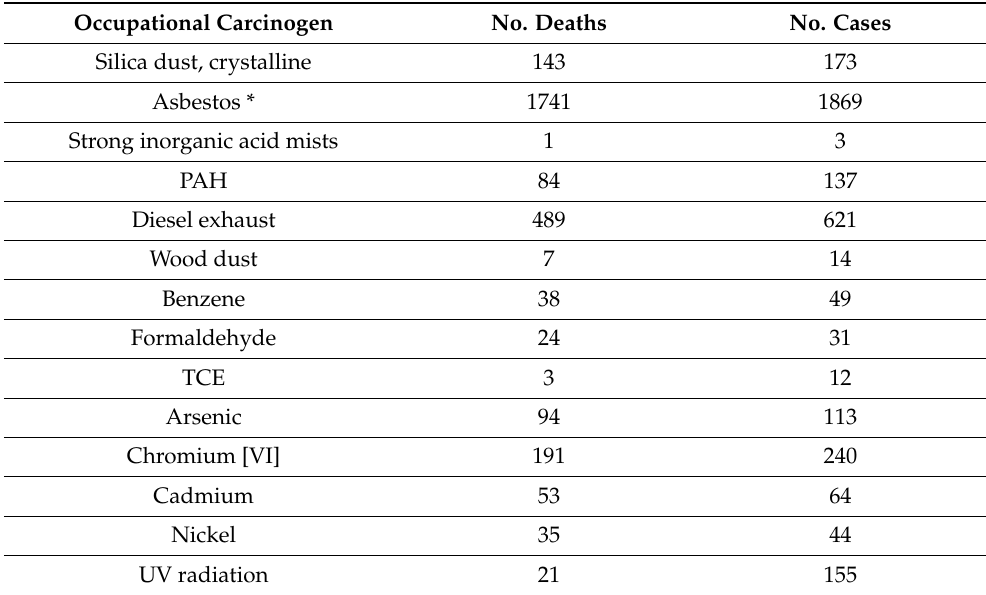
Table 3. Number of deaths in 2017 and cases in 2020 attributable to occupational carcinogens in Italy by agent.